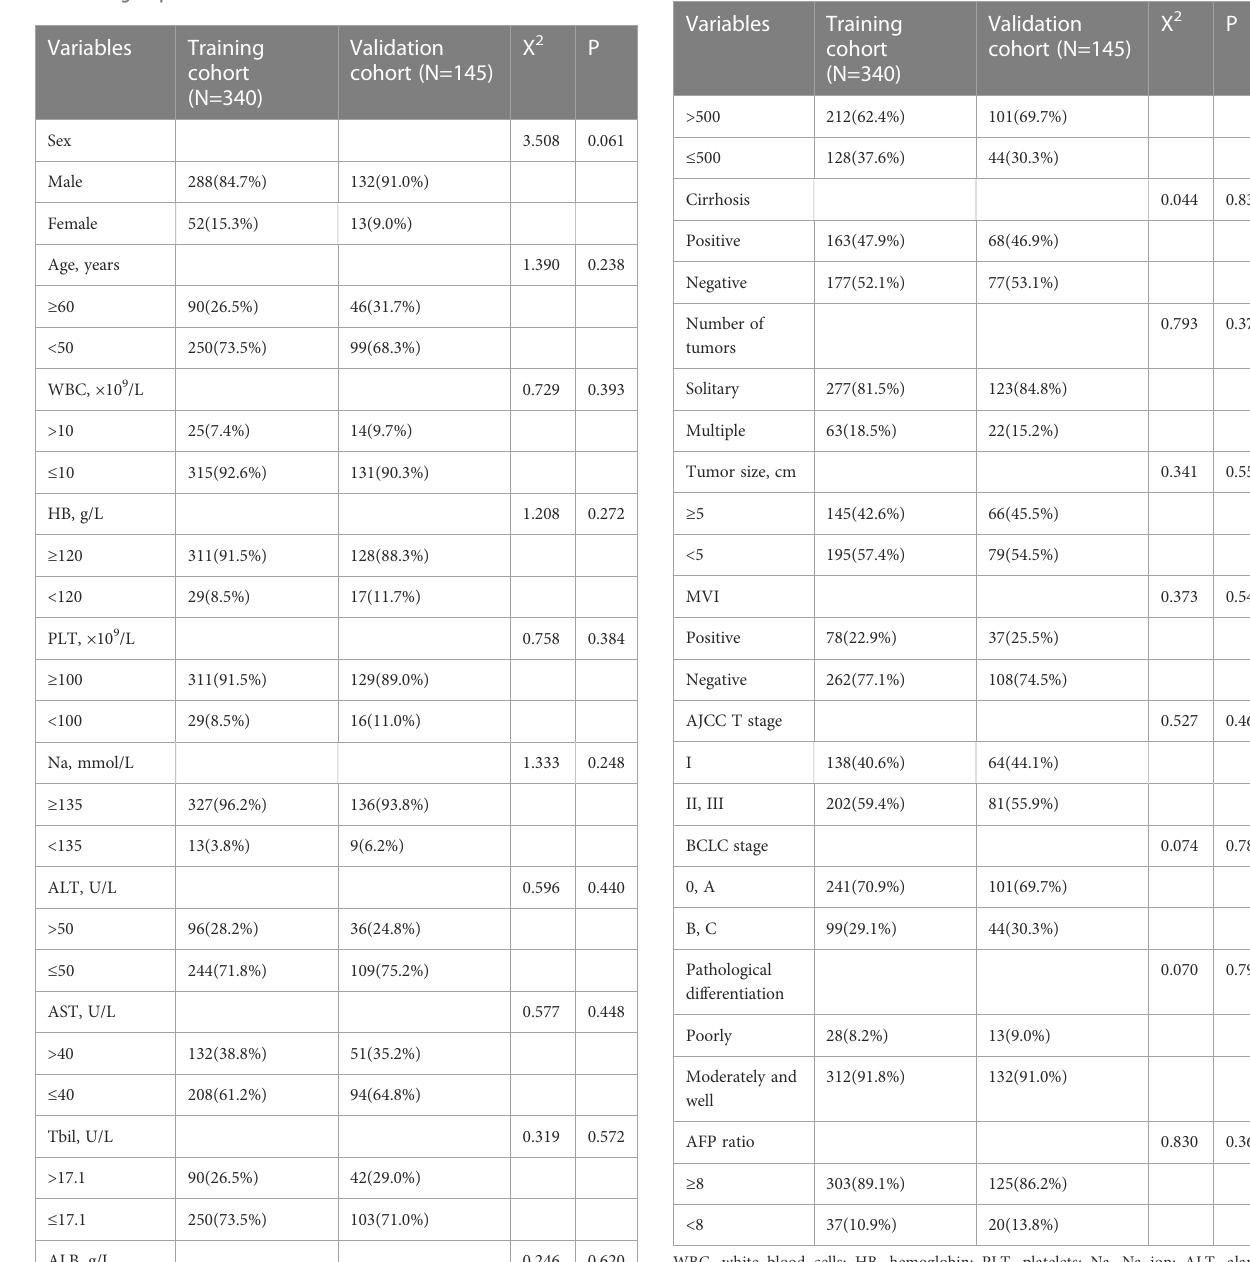
TABLE 1 Clinical characteristics of the training group and the validation